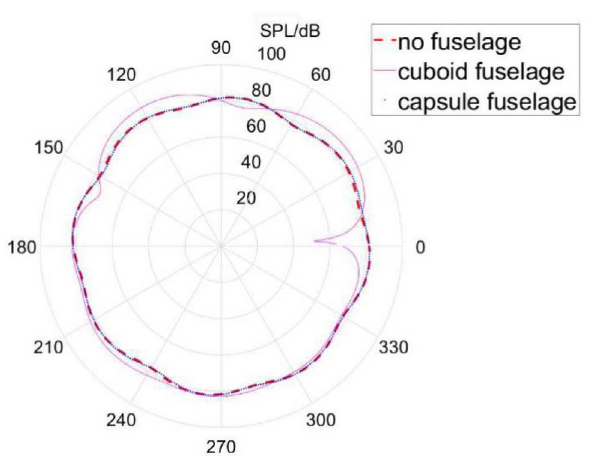
Figure 11. Acoustic noise scattering effects of cuboid fuselage and capsule